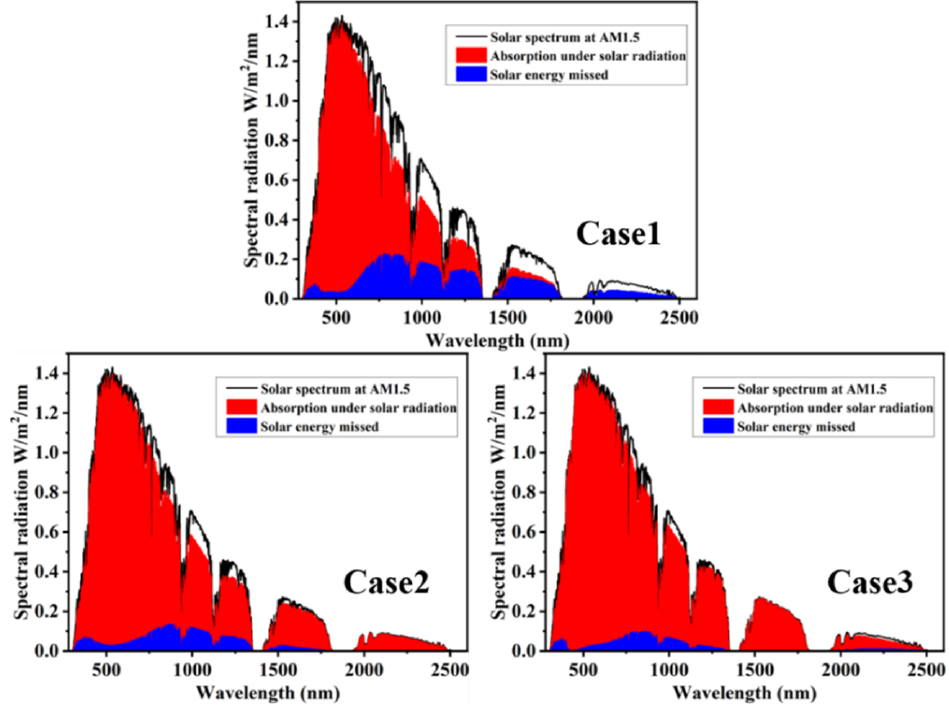
Figure 7. Solar absorption spectral for Case1 to Case3.